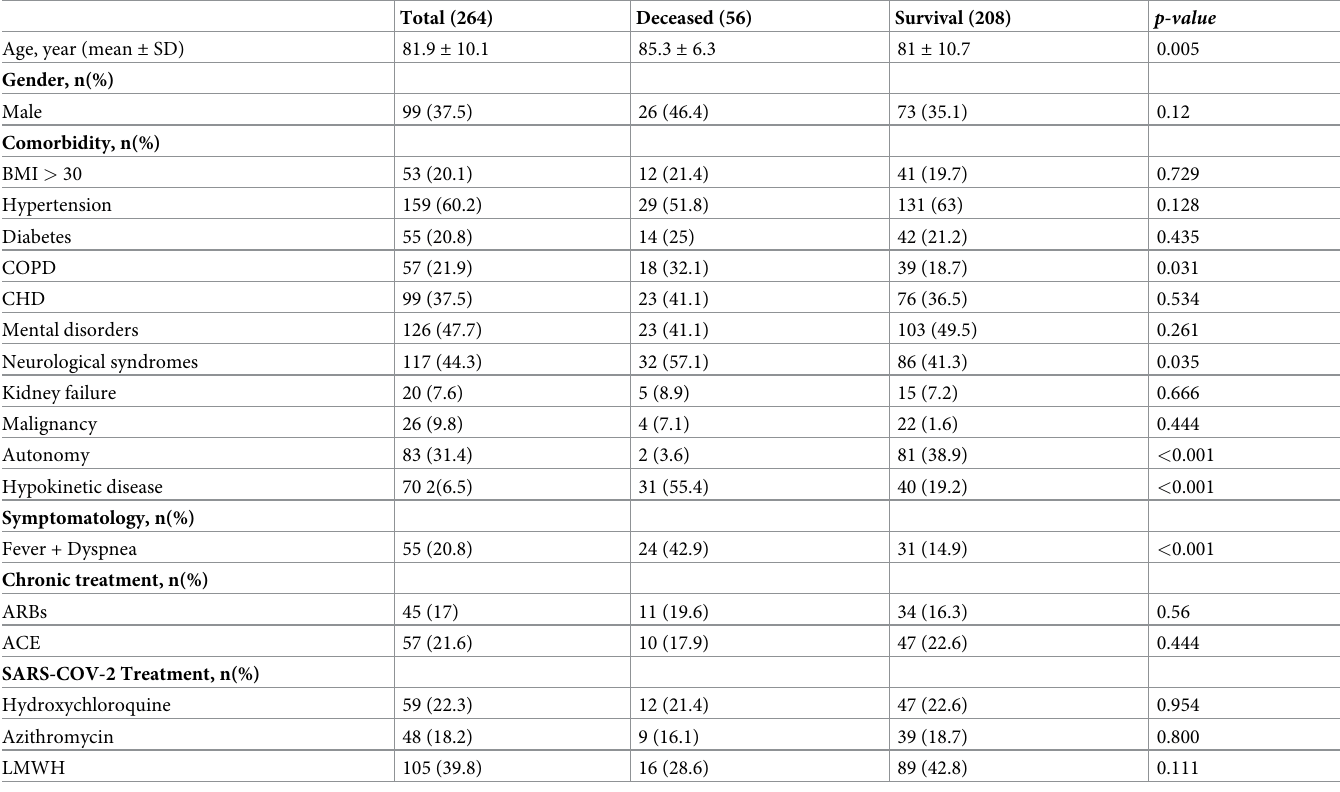
Table 3. Comparison of characteristics of 264 people living in retirement nursing homes with SARS-CoV-2 infection, divided into deceased and